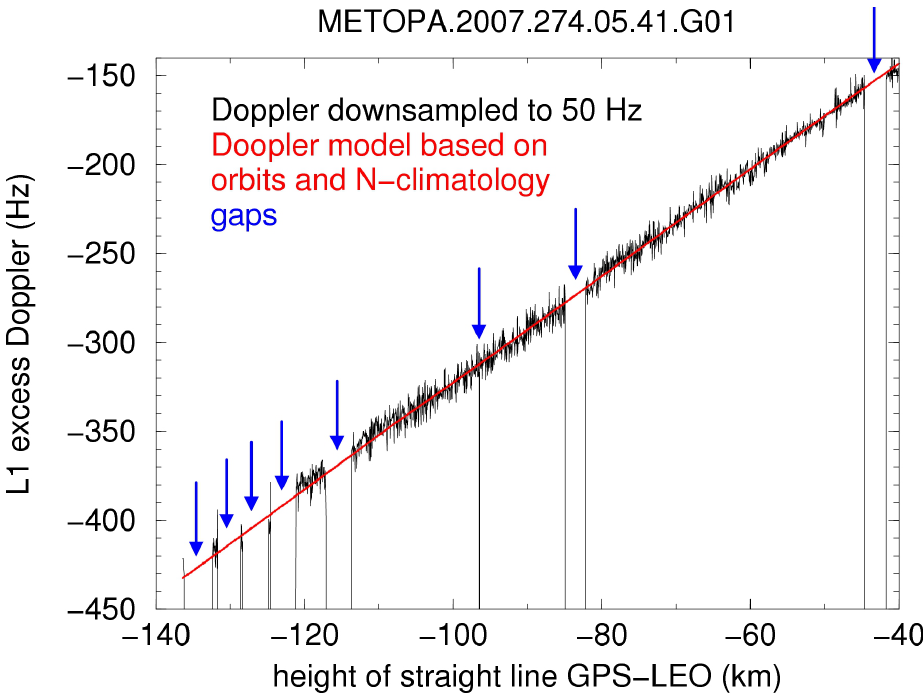
Fig. 10. Filling gaps in Metop/GRAS raw-sampled Doppler data with the model based on refractivity climatology.